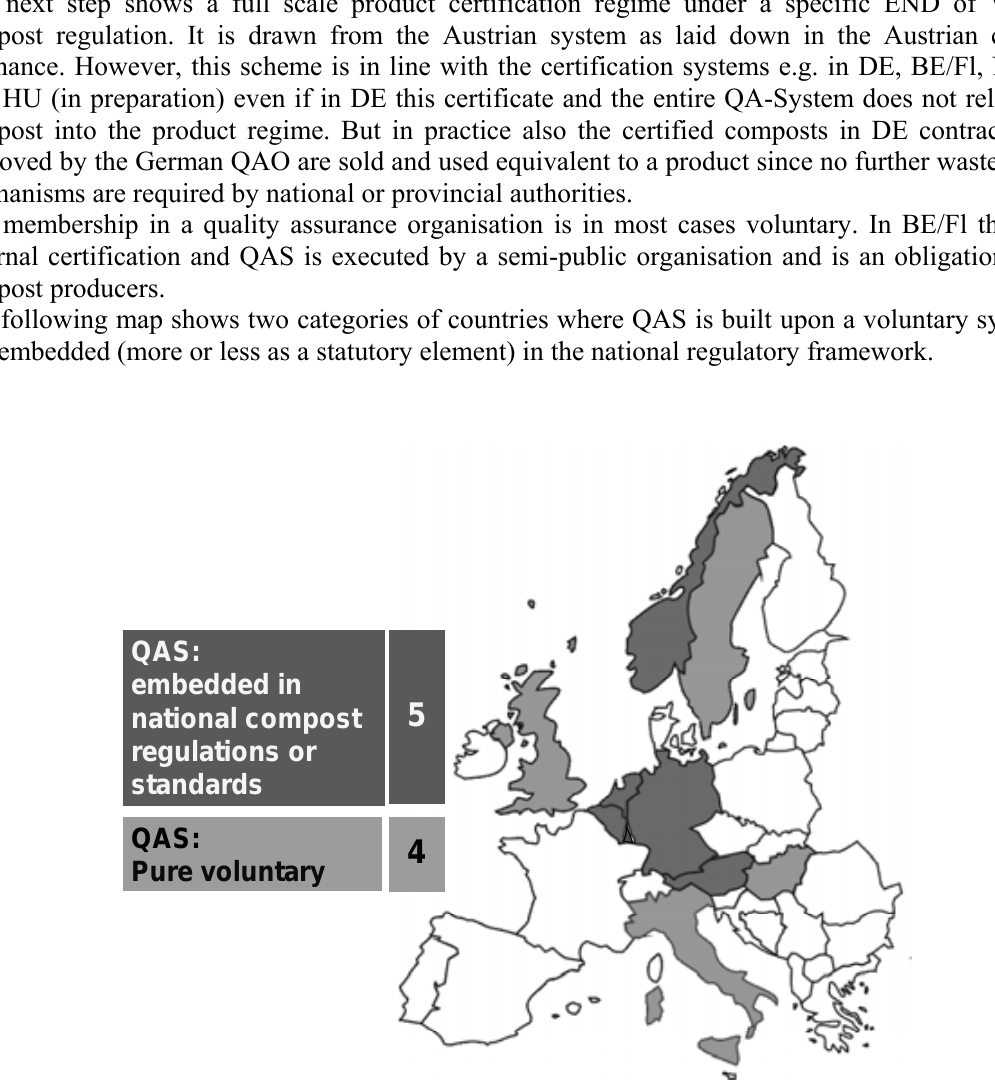
Figure 18: QAS – Quality assurance and certification schemes for compost in relation to national compost